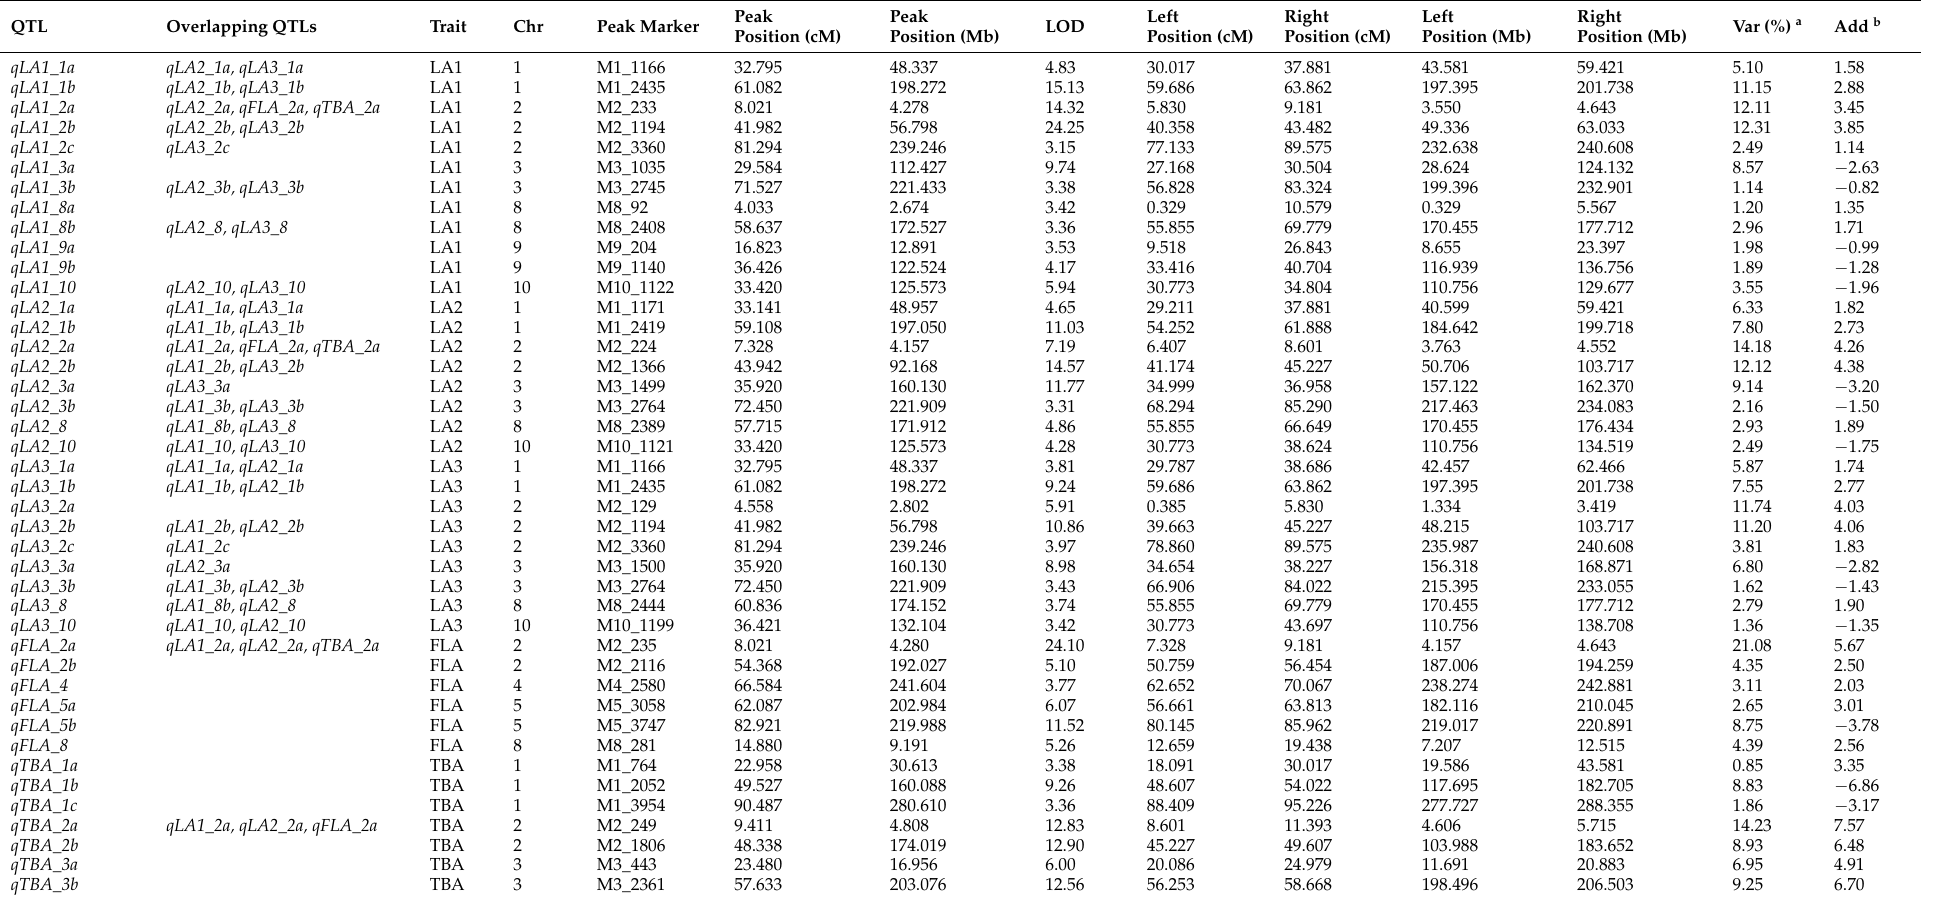
Table 2. Summary of the QTLs for lateral angles identified in this